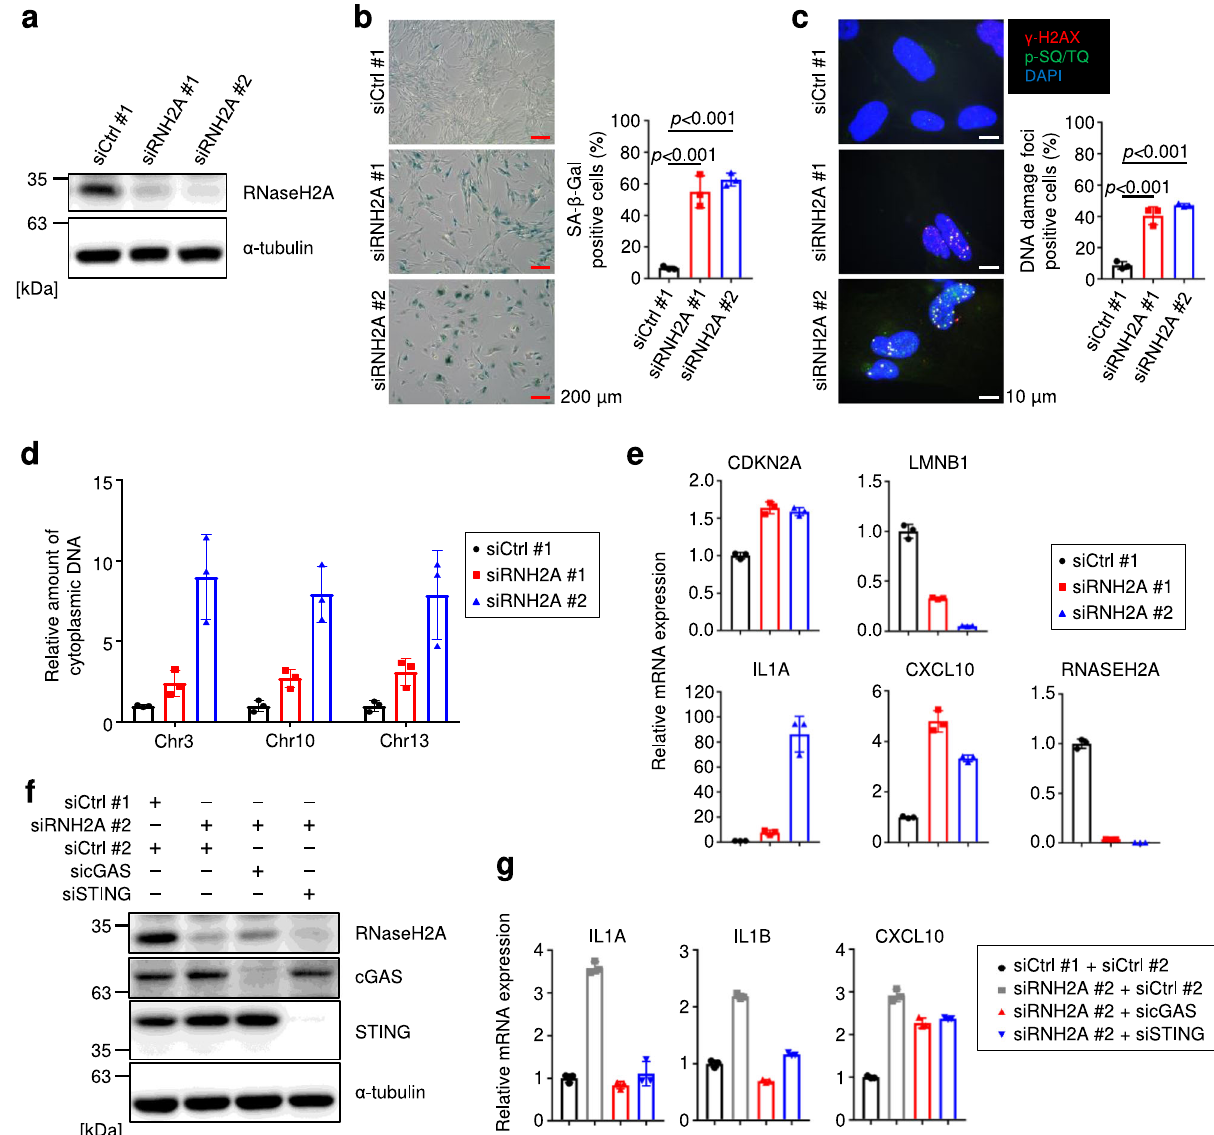
Fig. 4 RNaseH2A depletion induces cellular senescence in human fi broblast. a Western blot of pre-senescent TIG-3 cells treated with siRNAs (siRNH2A#1 and #2) for 72 h four times. Alpha-tubulin was used as a loading control. b Left: Representative images SA- β -Gal staining of TIG-3 cells as in a . Scale bars indicate 200 μ m. Right: Quanti fi cation of SA- β -Gal positive cells. The graphs indicate the percentage of SA- β -Gal positive cells. Error bars indicate the mean ± SD of biological triplicates. One-way ANOVA coupled with Dunnett ’ s multiple comparisons test. c Left: Representative immuno fl uorescence images of DNA damage marker of TIG-3 cells as in a . γ -H2AX (red), phospho-Ser/Thr ATM/ATR (p-SQ/TQ) substrate (green) and DAPI (blue). Scale bars indicate 10 μ m. Right: Quanti fi cation of DNA damage-positive cells. The graphs indicate the percentage of nuclei containing more than two foci positive for both γ -H2AX and p-SQ/TQ. Error bars indicate the mean ± SD of biological triplicates. One-way ANOVA coupled with Dunnett ’ s multiple comparisons test. d Quantitative PCR analysis of chromosomal DNA in the cytoplasm of TIG-3 cells as in a using primers against chromosomes 3, 10 and 13. Error bars indicate the mean ± SD of technical triplicates. e RT-qPCR analysis of the indicated genes using RNA extracted from TIG-3 cells as in a . Error bars indicate the mean ± SD of technical triplicates. f Western blot of TIG-3 cells depleted of RNaseH2A, cGAS or STING by siRNA. Alpha-tubulin was used as a loading control. g RT-qPCR analysis of indicated genes using RNA extracted from TIG-3 cells as in f . Error bars indicate the mean ± SD of technical triplicates. All data were representative of at least three biological